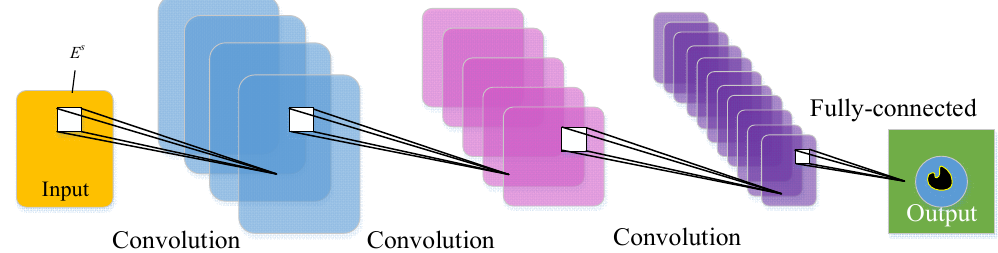
Figure 2. Structure of the convolutional neural network in this paper. 𝐸 (cid:3046) is fed into the network as a 32 × 32 matrix form as an input into the convolutional network. The perceptual field size in the network is 5 × 5, and the feature data is evaluated in the pooling layer with a 2 × 2 pooling operation. Finally, a 100 × 100 regression value is involved as the output for imaging through the fully connected